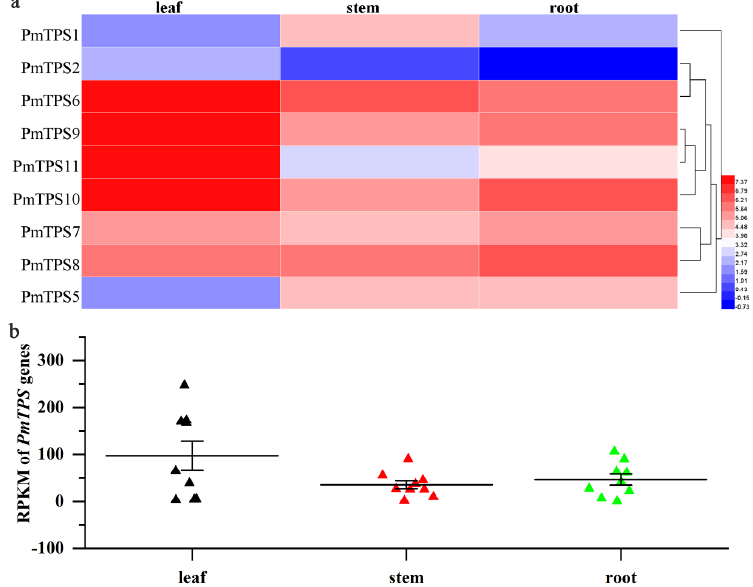
Figure 9. Expression patterns of PmTPS s among leaf, stem, and root tissues of Prunus mume . ( a ) The heat map represents the expression levels of nine PmTPS s among leaf, stem, and root tissues. Data of gene expression levels (RPKM, Reads Per Kilobase of exon model per Million mapped reads) was normalized by log 2 transformed data. Red and blue indicate high- and low-expression profiles, respectively. ( b ) The scatter plot figure shows RPKM values of nine PmTPS s in leaf, stem, and root tissues.